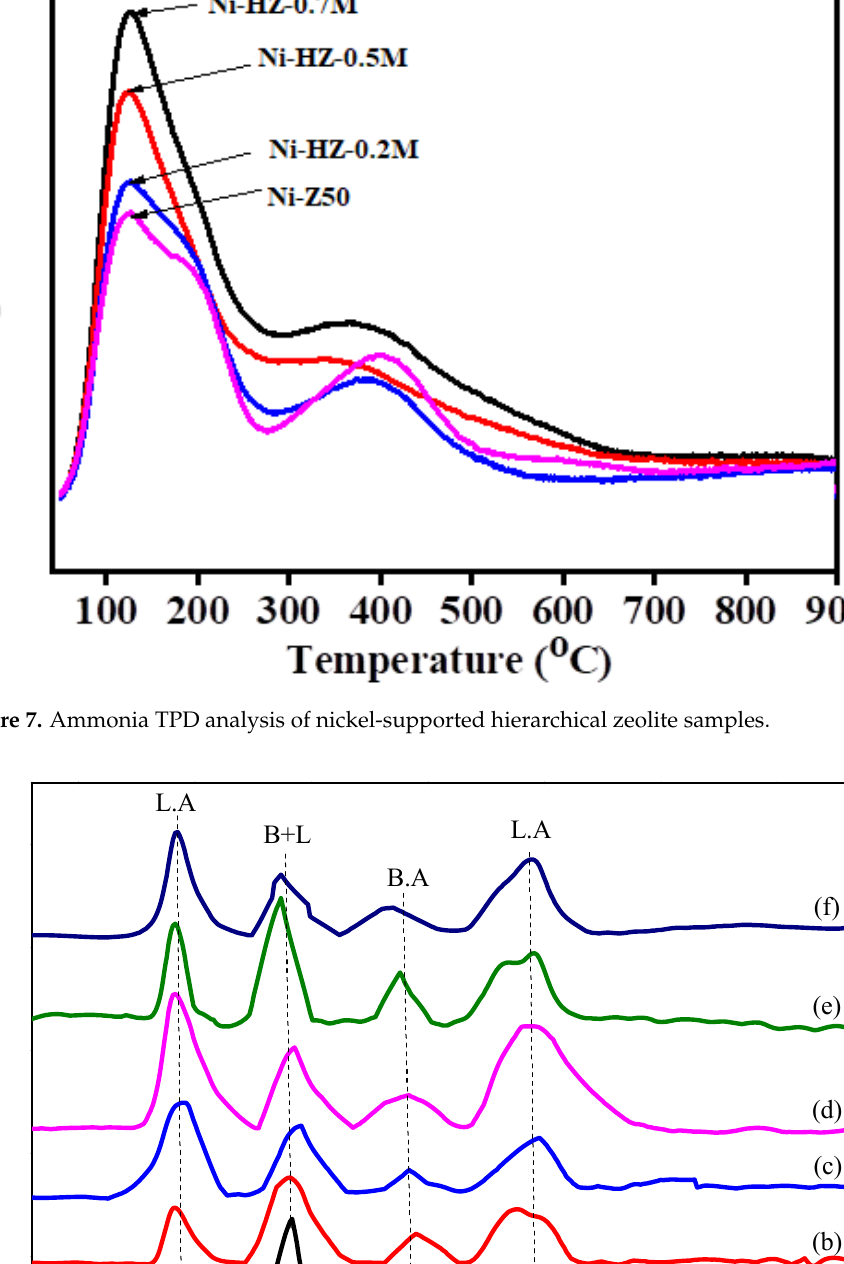
(c) Ni-HZ-0.5 M, (d) Ni-HZ-0.7 M, (e) Ni-USY80, and (f) Ni-HZ-USY80. Herein, LA and BA are ( c ) Ni-HZ-0.5 M, ( d ) Ni-HZ-0.7 M, ( e ) Ni-USY80, and ( f ) Ni-HZ-USY80. Herein, LA and BA are